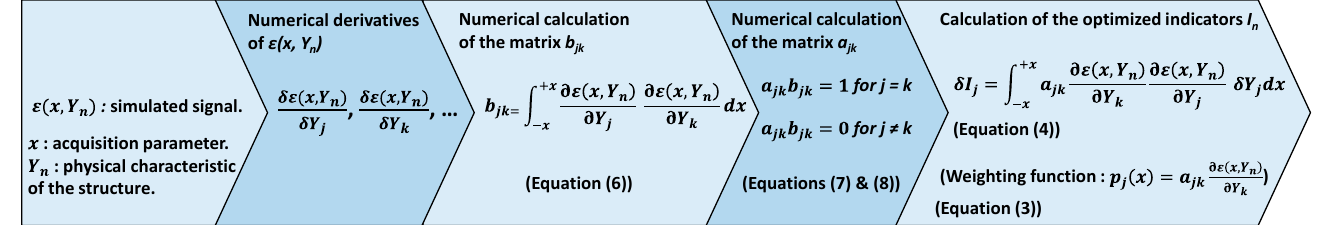
Figure 1. Flowchart for the determination of weighting functions and optimized indicators of a